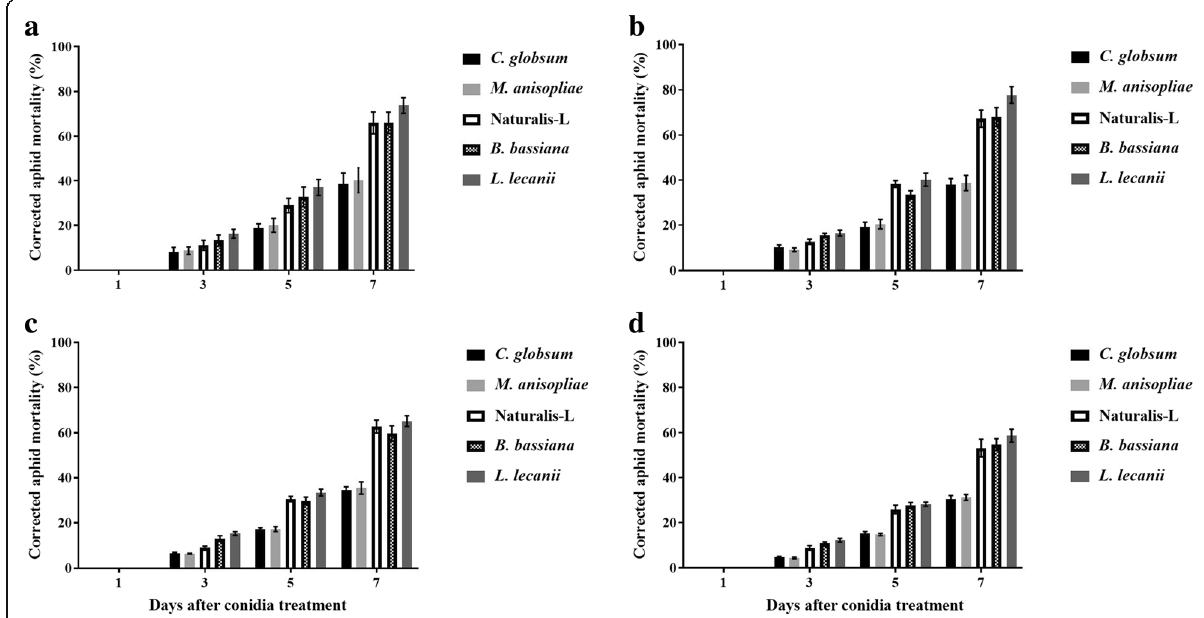
Fig. 1 The corrected mortalities (mean ± SE) of a A. gossypii , b M. persicae , c A . fabae and d M. euphorbiae treated with conidia of four isolates of entomopathogenic fungi and commercial formulation (Naturalist®) at 20 °C and 80% RH. The conidial concentration of each fungal isolate used for treatment was 1 × 10 7 conidia ml −